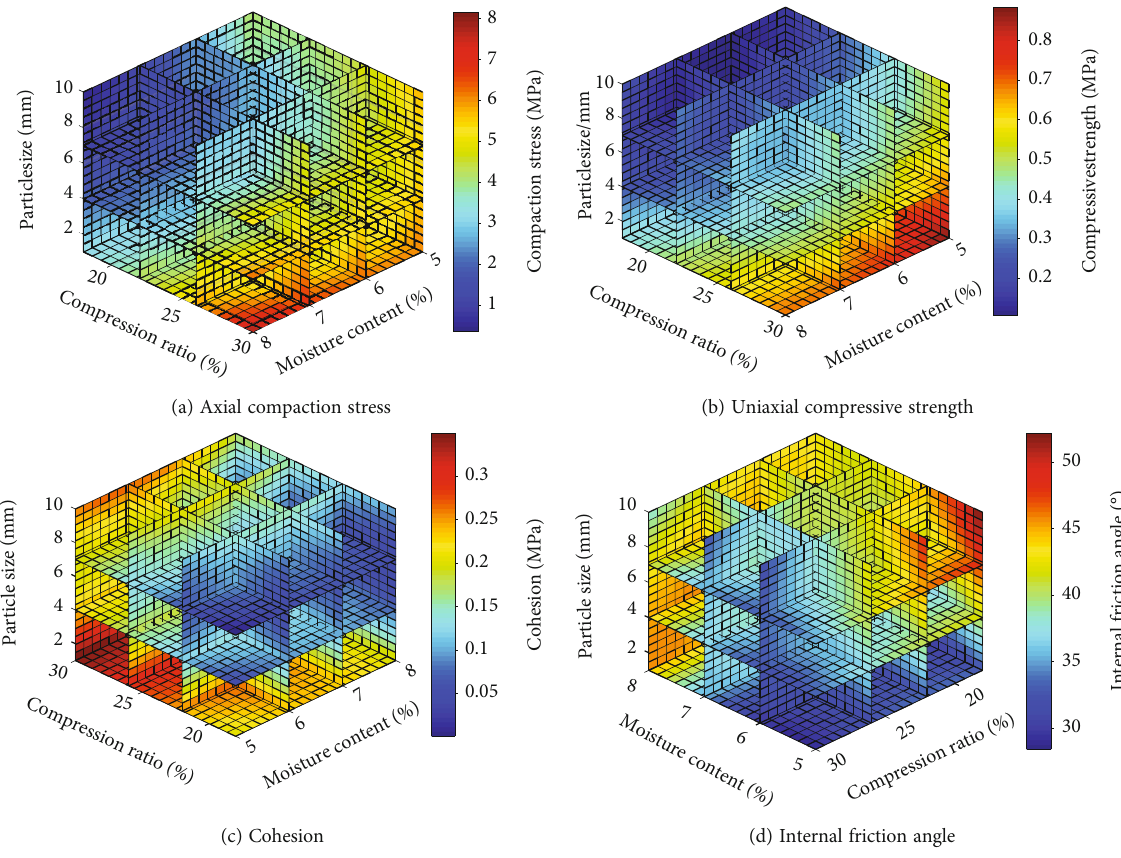
Figure 13: Mathematical model of the objective